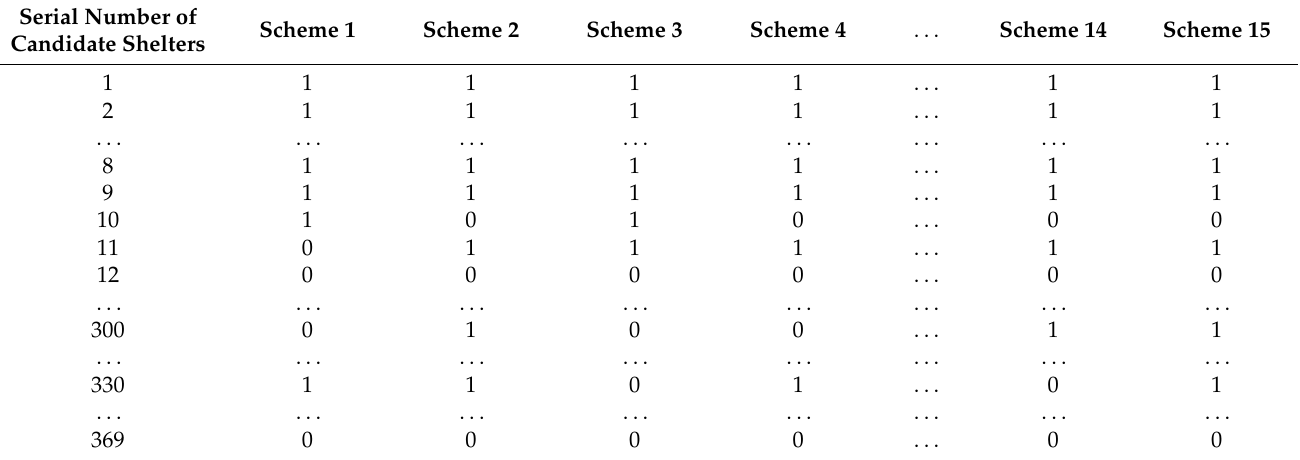
Figure 7. The relationship between the fitness function value and the number of iterations. Table 4. The shelter location schemes in the first